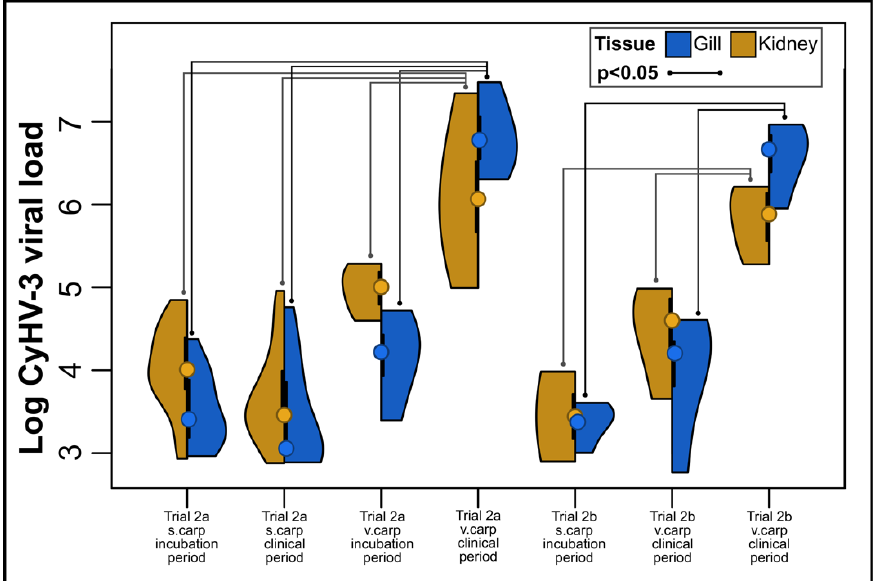
Figure 7. CyHV-3 viral loads in trial 2. Points in split violin plots indicate mean values and black lines indicate standard error. Violin plot areas indicate the distribution of CyHV-3 viral load values. Inset box indicates the tissue type (blue = gill tissue, kidney = kidney tissue) and statistically significant pairwise comparisons.